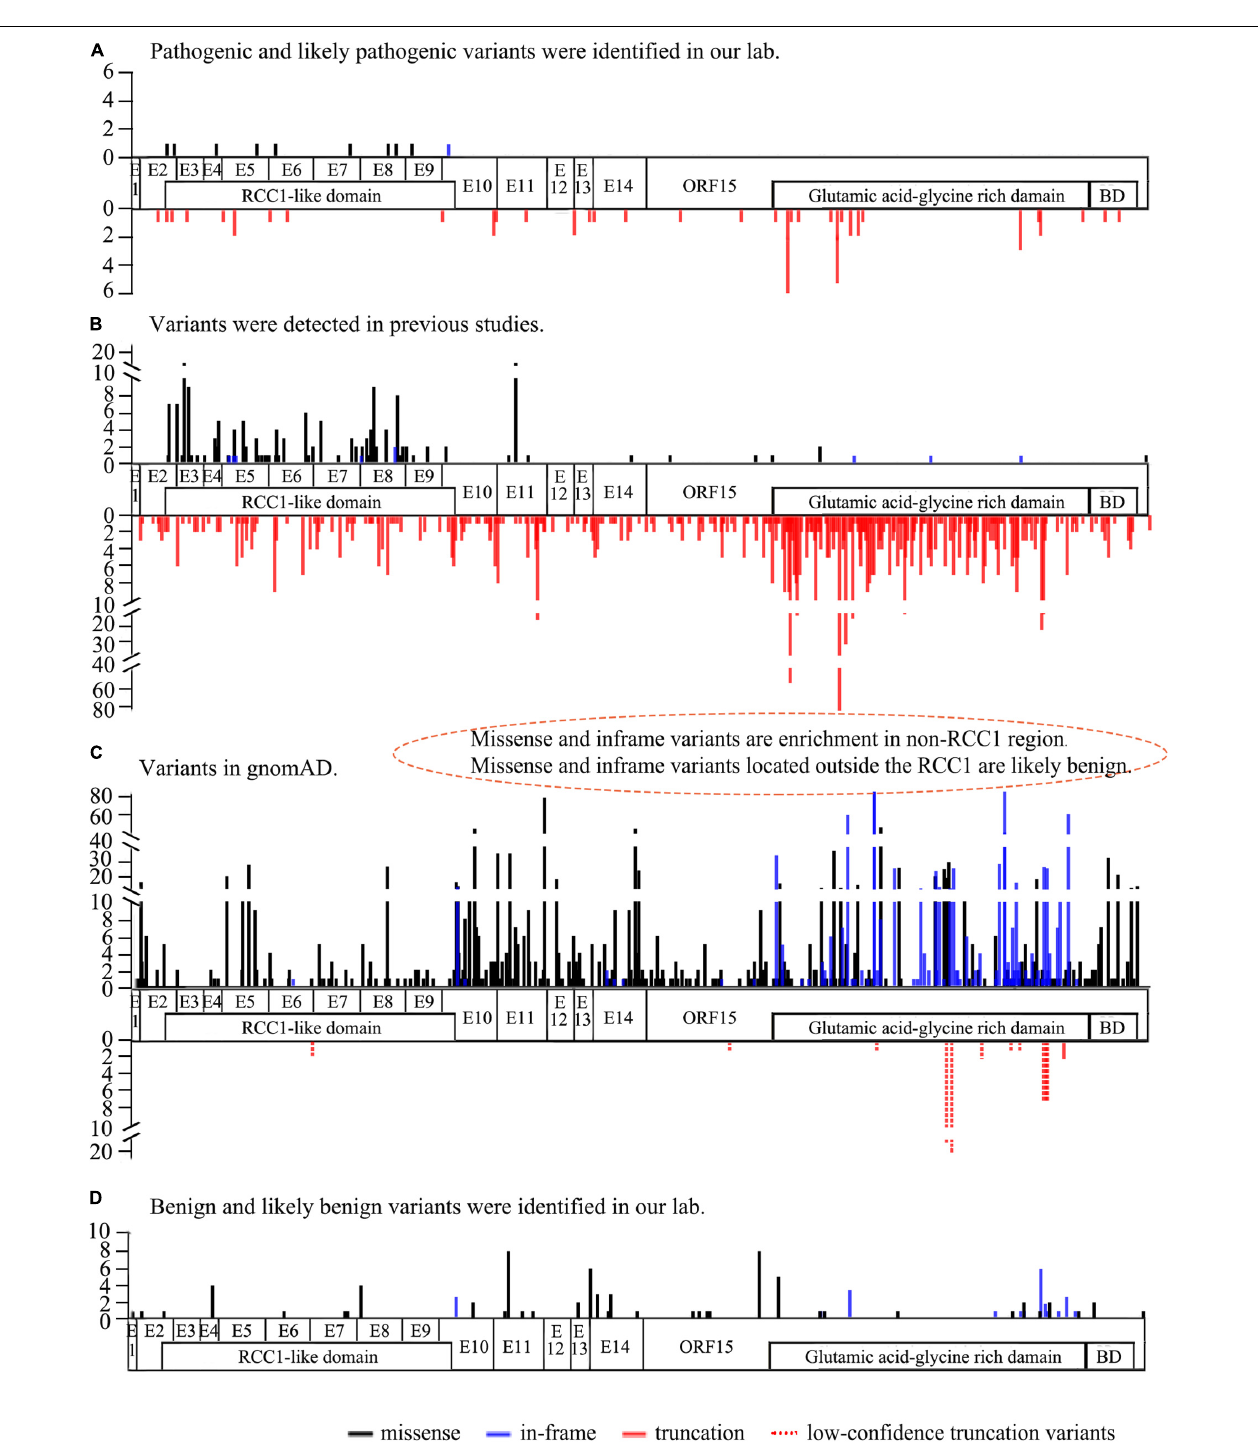
FIGURE 1 | The frequency and location of the variants from our lab, previous studies, and the gnomAD database (Ref. NM_001034853). (A) The frequency and location of pathogenic and likely pathogenic RPGR variants detected in our lab. Missense and in-frame variants are distributed above the structure, and truncation variants are shown below the structure. (B) The frequency and location of RPGR variants identified in previous studies. Missense and in-frame variants enriched in the RCC1-like domain are shown above the structure, and truncation variants are indicated below the structure. Gross deletion variants are not shown here. (C) The frequency and location of RPGR variants from the gnomAD database. Missense and in-frame variants are significantly enriched in the non-RCC1-like domain above the structure. Truncation variants in all coding regions below the structure. Of the 11 truncation variants, 10 were low confidence truncations (dotted line). (D) The frequency and location of benign and likely benign RPGR variants identified in our lab. The white regions represent the coding regions. RCC1-like domain: p.38 ∼ 367, BD: basic domain p.1086-1139, Glutamic acid-glycine-rich domain: p.728 ∼ 1084.